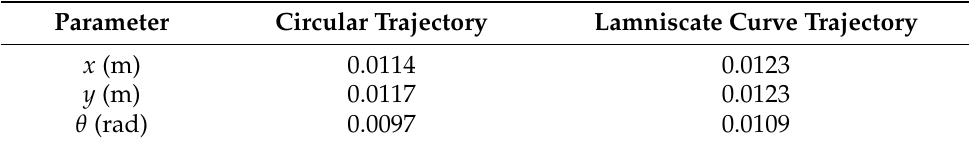
Table 3. Root mean square error (RMSE) of trajectory